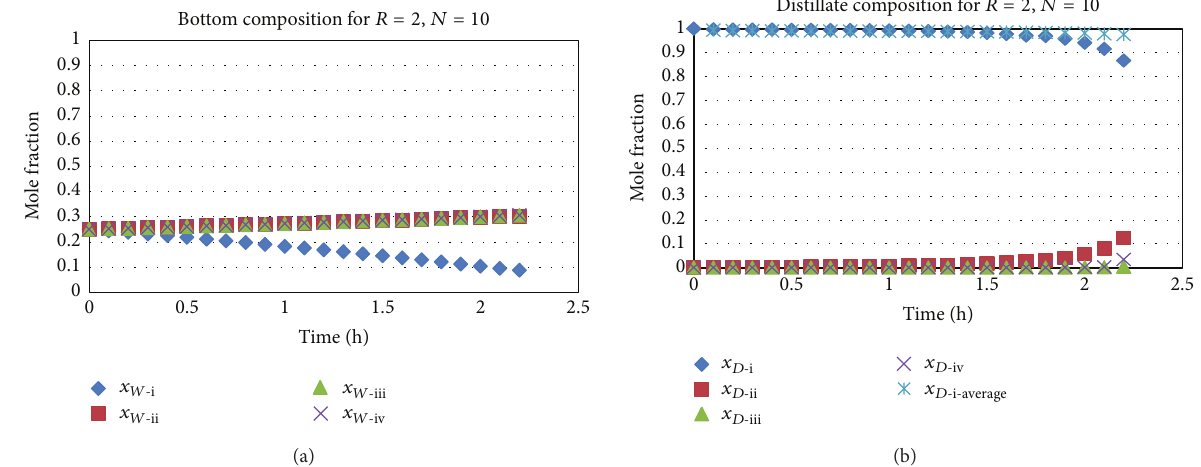
Figure 2: Results for four components batch distillation with short-cut method at constant reflux of 2.0; (a) bottom composition, (b) distillate